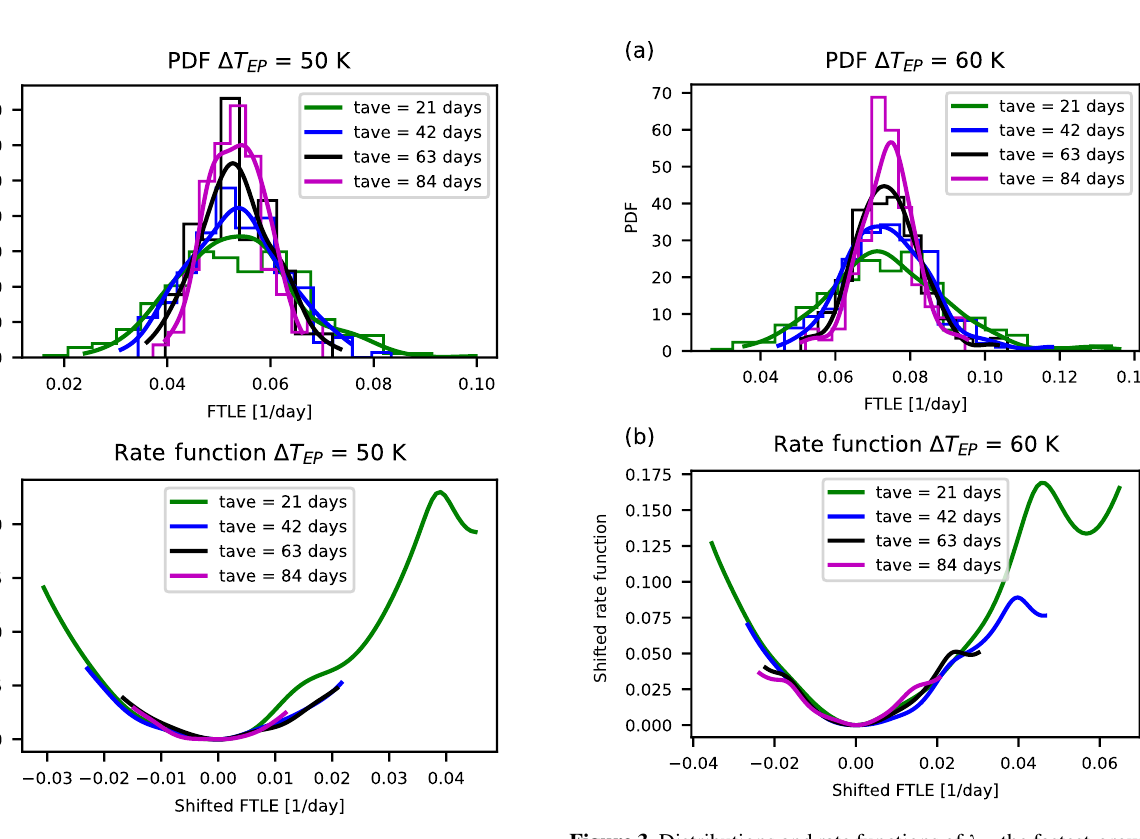
Figure 2. Distributions and rate functions of λ 1 , the fastest-growing instability in PUMA, for (cid:49)T EP = 50K. Panel (a) shows the differ- ent distributions and their kernel-smoothing approximation of σ 1 m where t ave is the respective 3m. Panel (b) shows a comparison of the rate functions, with the minimum moved to zero.